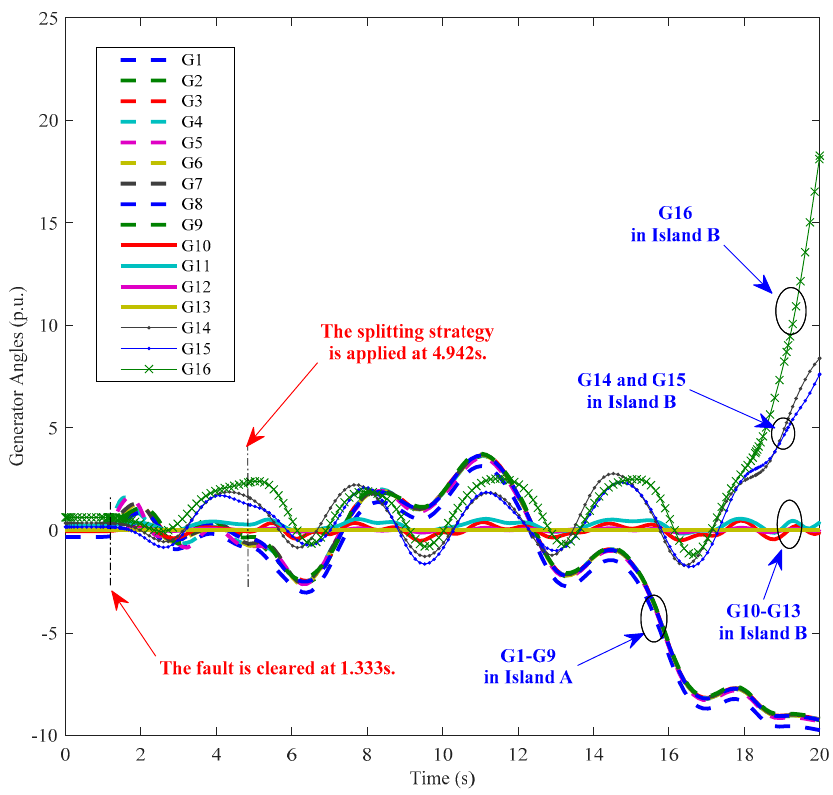
Figure 5. Generator angles of the power system after splitting beyond CIT.